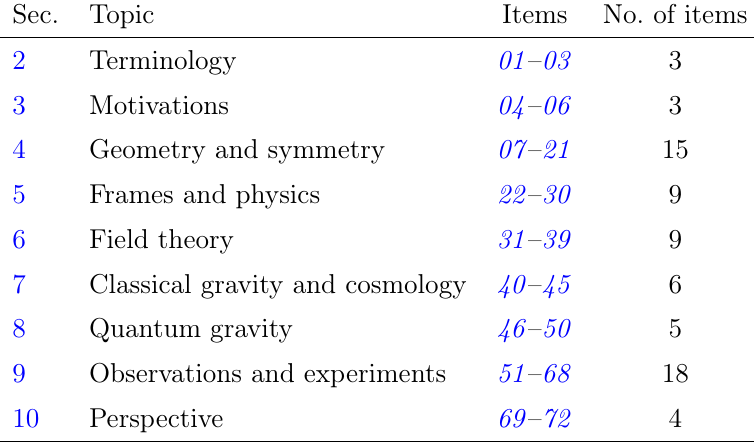
Table 1 . Summary of the questions per